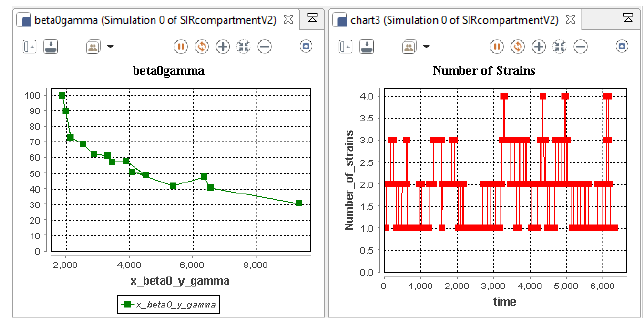
Figure 9. The result